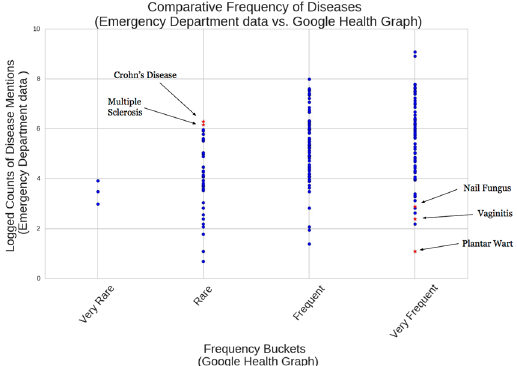
Figure 5. Comparison of disease frequency for the ‘adult’ age bracket (40–60 years old). The y-axis shows the number of identified diseases in the emergency department data. The x-axis records the expected frequency of diseases according to the Google health knowledge graph for the ‘adult’ age bracket. The points highlighted demonstrate instances of frequency misalignment due to the differences in populations